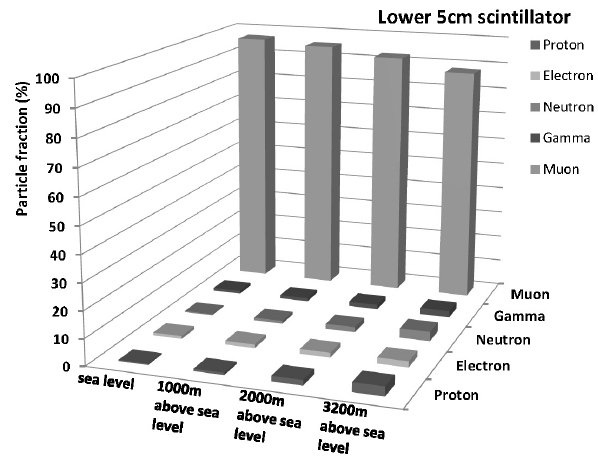
Fig. 6. Fractions of elementary particles detected by the lower layer of the SEVAN